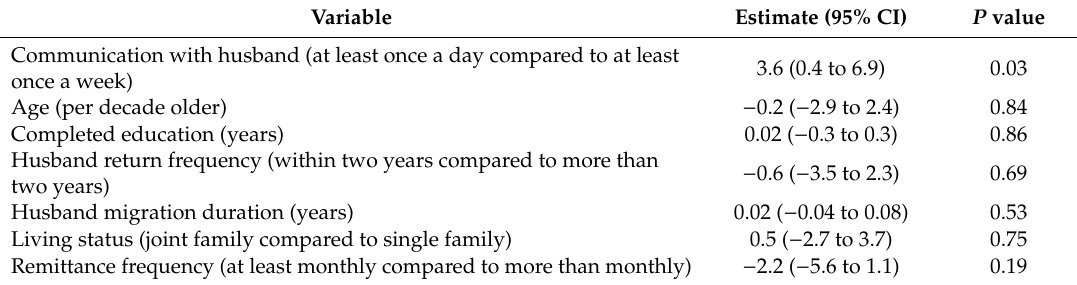
Table 4. Association of the mean CD-RISC score with the “communication with husband” variable in a multiple linear regression model, adjusting for confounding